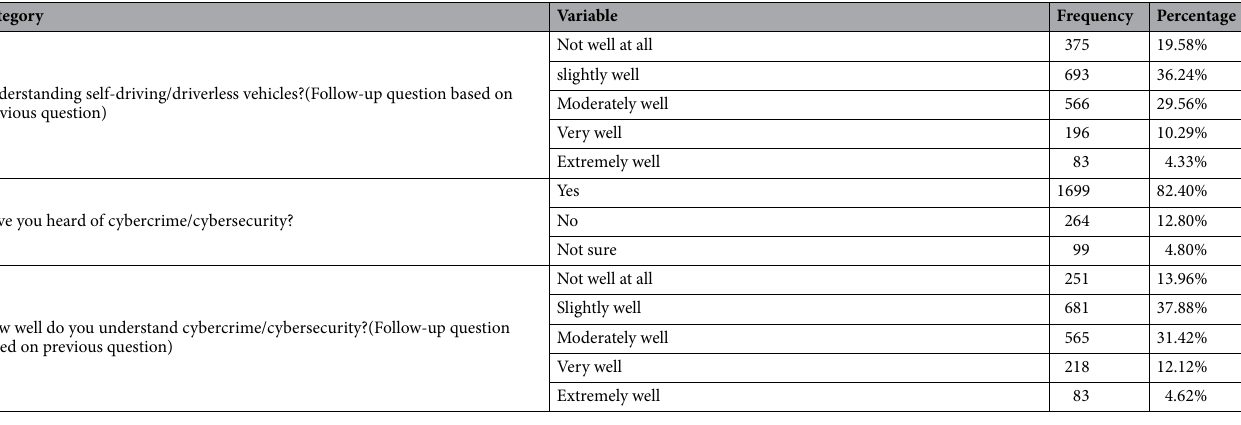
Table 1. Demographics and characteristics of participants.